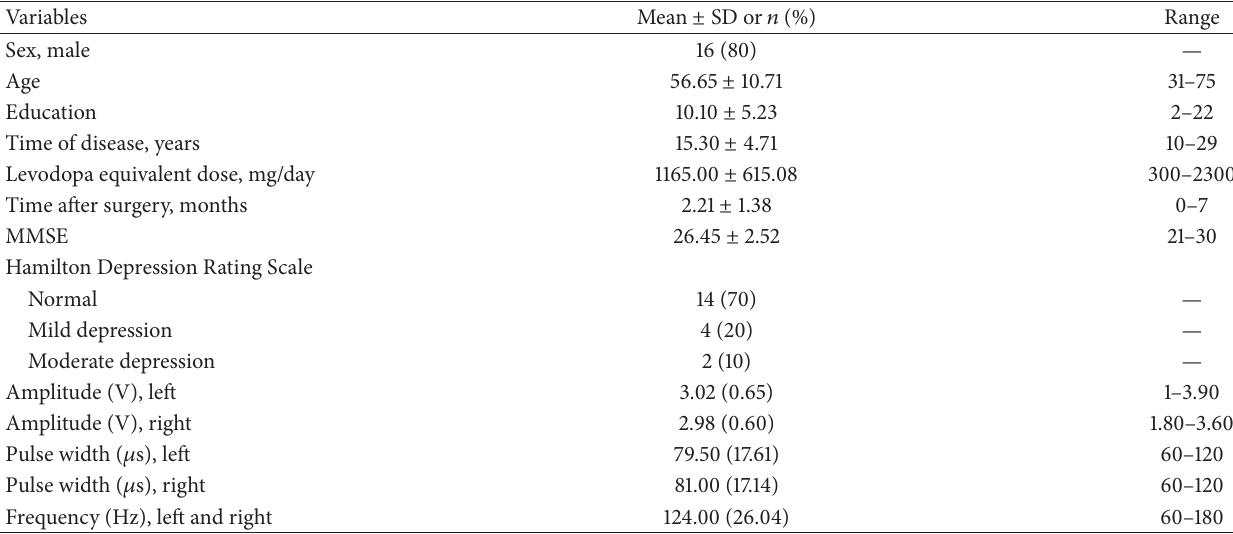
Table 1: Baseline characteristics of the